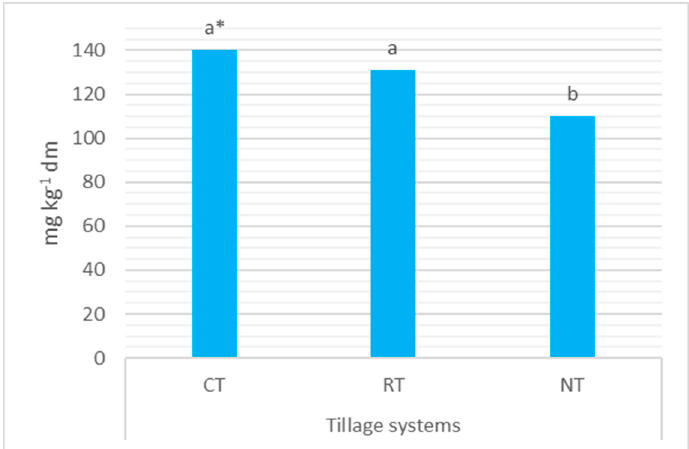
Figure 7. Content of N-NH 4 in the 0–25 cm soil layer depending on the tillage system (average of 2014–2016). * a—Means denoted with the same letters do not differ significantly, p < 0.05.